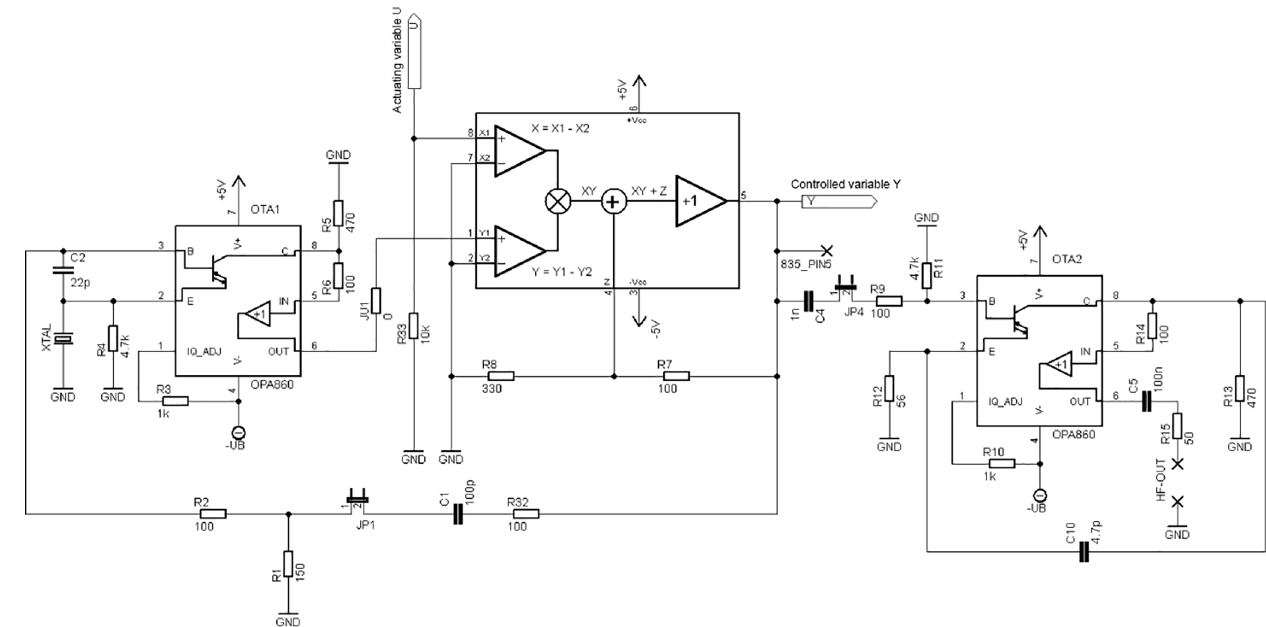
Figure 7. Front-end of our QCM circuit with the oscillator (built with the quartz XTAL and OTA1), the analogue multiplier AD835, the feedback-network (R1, R2, C1, and R32) and the output amplifier (around OTA2), which generates the HF-OUT-signal. The controlled variable Y is the amplitude of the